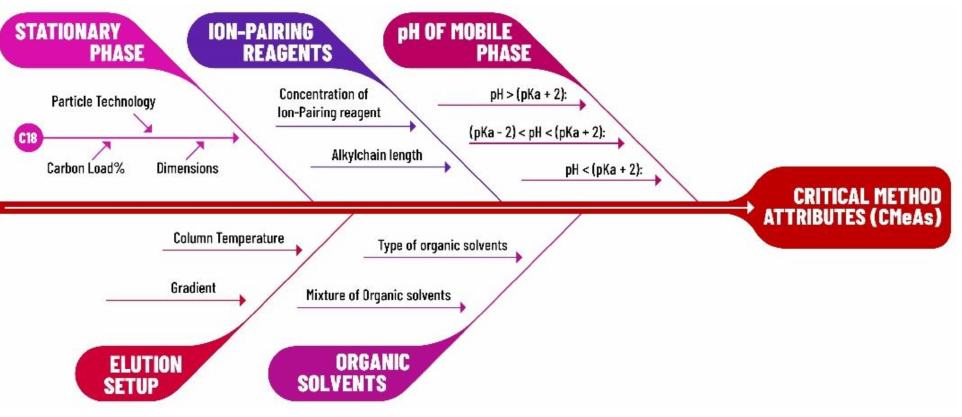
Figure 3. Proposed Ishikawa fishbone diagram for the assessment on CMeAs and CMePs, modified from Guiraldelli